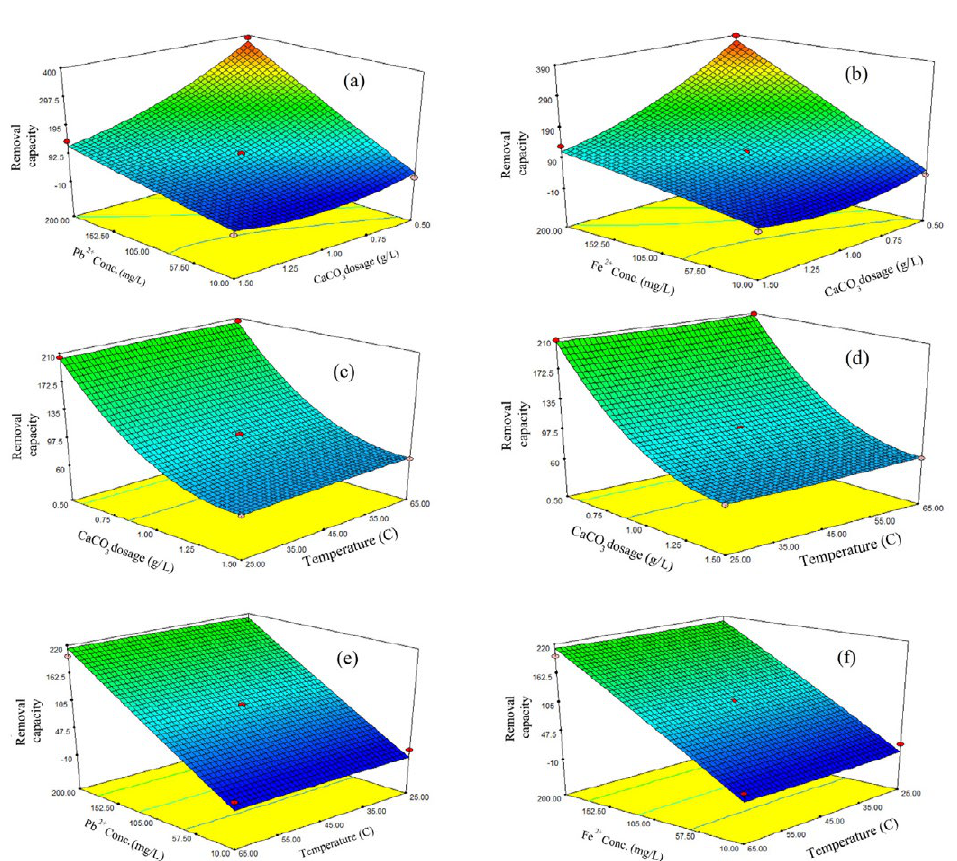
Fig. 6: 3D response surface diagrams showing the effects of mutual interactions between two independent variables.